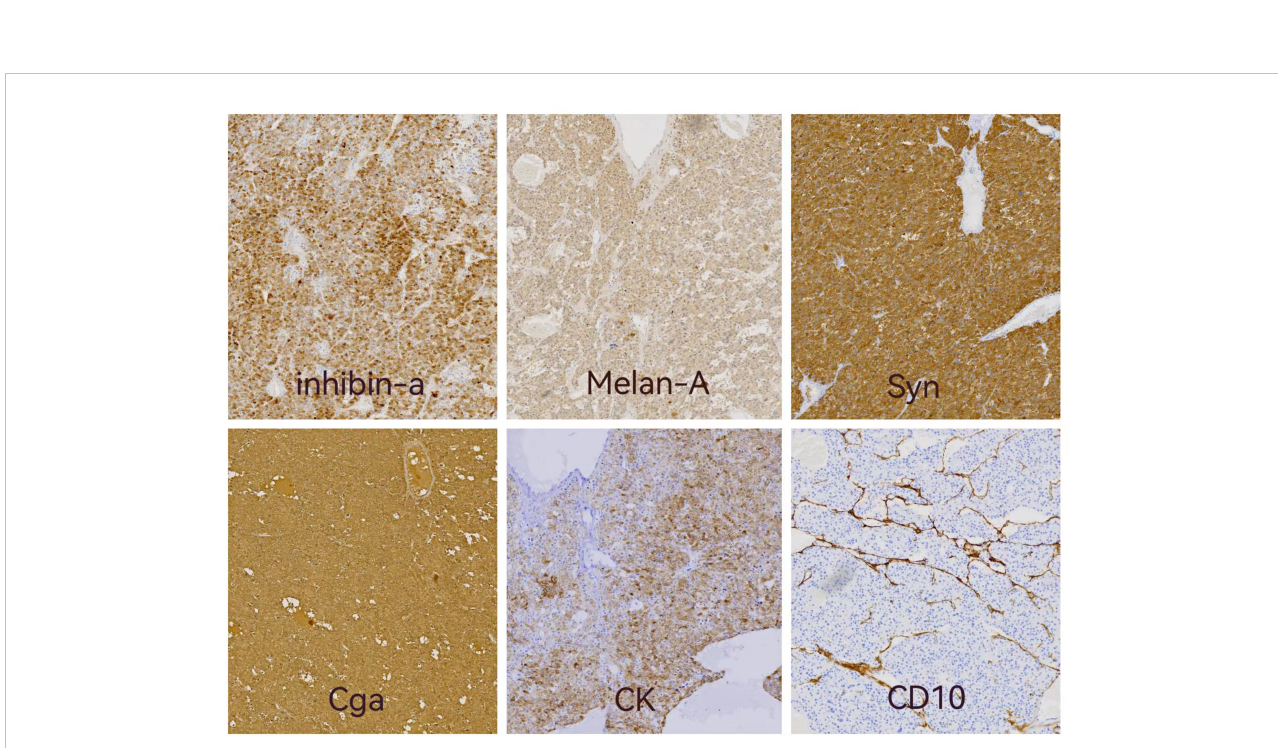
FIGURE 3 Immunohistochemistry results: immunostaining of inhibin-a, Melan A,Syn and CK showed positive in cytoplasmic. Cytoplasmic and nuclear staining were positive of Cga and CD10 showed positive in intercellular fi brous